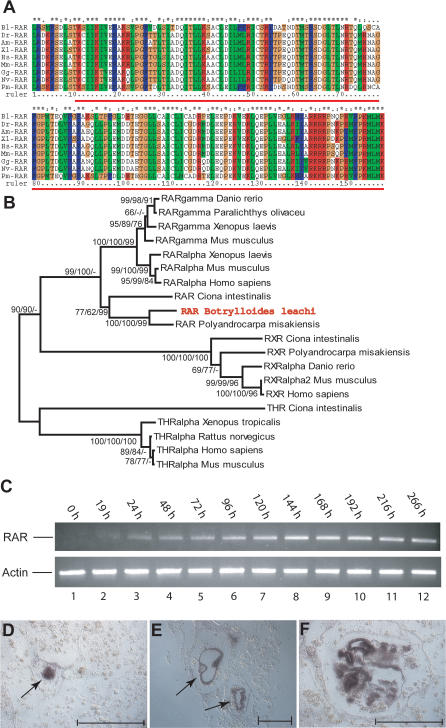
Cloning and Expression Pattern of the RA Receptor Homologue during WBR(A) A fragment of 157 amino acid exhibiting high homology to the ligand-binding domain (marked by a red line) of hormone receptors present in all RARs.(B) An evolutionary tree of different RARs, retinoic X receptors, and thyroid hormone receptor members of this family of RA receptors in different urochordates and vertebrates. Molecular evolutionary analysis was conducted using the MEGA 2.1 program using the tree-making method Minimum evolution. The numbers along the outer side of each branch represent the bootstrap values in percentage (1,000 reps) of three different tree-making methods: the selected tree, Minimum evolution/ Neighbor-joining/ Maximum parsimony. The sign “-“ marks bootstrap values that are less than 50% or a complete different outcome of the specific branch compared to the same branch in the selected tree.(C) RT-PCR analysis was performed on regenerating ampullae at different developmental stages. Intact blood vessels (the controls) did not express the RAR transcript (lane 1) while as early as 19 h postseparation, the transcripts were detectable and showed a gradual increase in their levels along the entire process (lanes 2–12). Actin levels remained equal representing the viability of the regenerating ampullae and serve as a positive control to normalize RAR levels.(D–F) Whole-mount RNA in situ hybridization was employed on paraffin sections of regenerating ampullae at different developmental stages. Specific staining pattern was visible from day 2 (D) (arrow) in aggregates of blood cells in the regenerating niches. In cases where several regeneration niches were established and buds developed simultaneously within the ampullae, RAR expression pattern was localized specifically to all buds (E) (arrows). Later on, RAR continued to specifically stain regenerating buds through the subsequent developmental stages of spheres, invaginations and organogenesis (F). Scale bar represents 100 μm.Bl, B. leachi; Brl, Branchiostoma lanceolatum; Dr, Danio rerio; Gg, Gallus gallus; Hs, Homo sapiens; Mm, Mus musculus; Nv, Notophthalmus viridescens; Pm, P. misakiensis; Xl, Xenopus laevis.